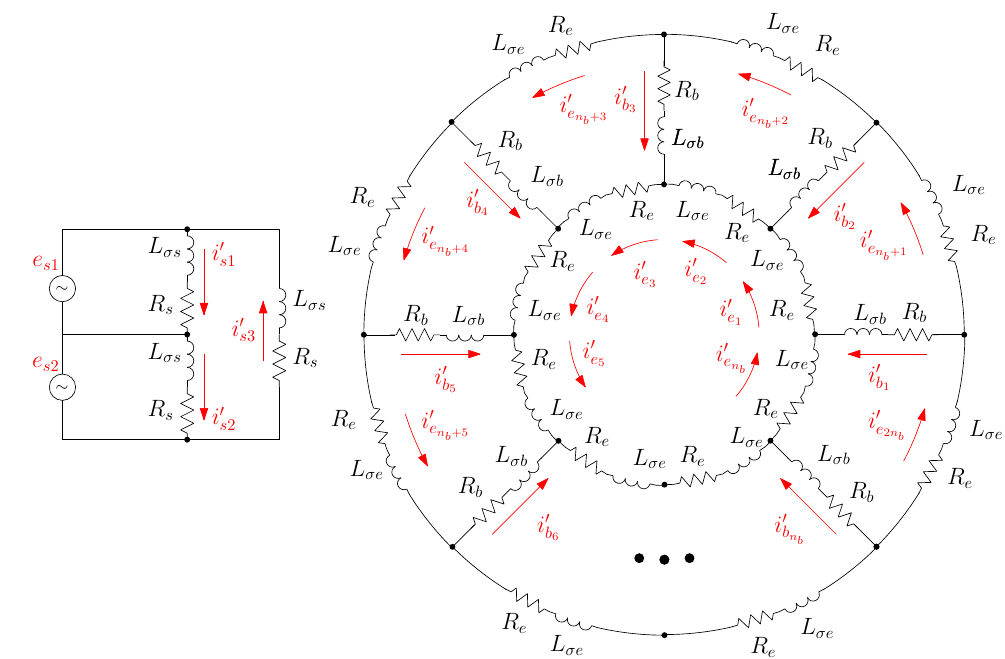
Figure 5. Interconnections of the elements the primitive IM